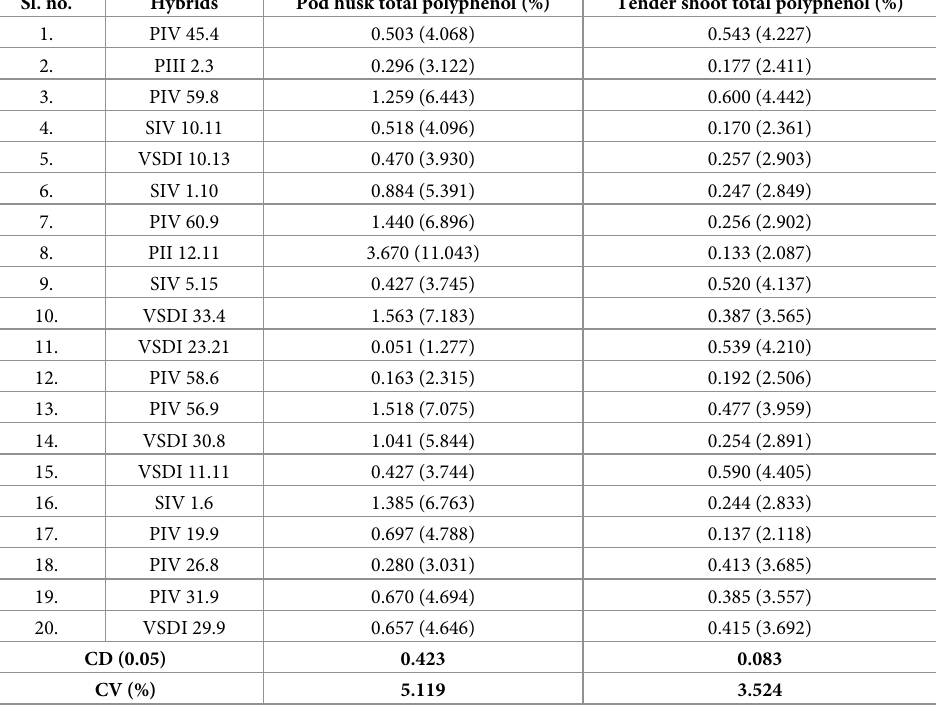
Table 4. Total polyphenol content in pod husk and tender